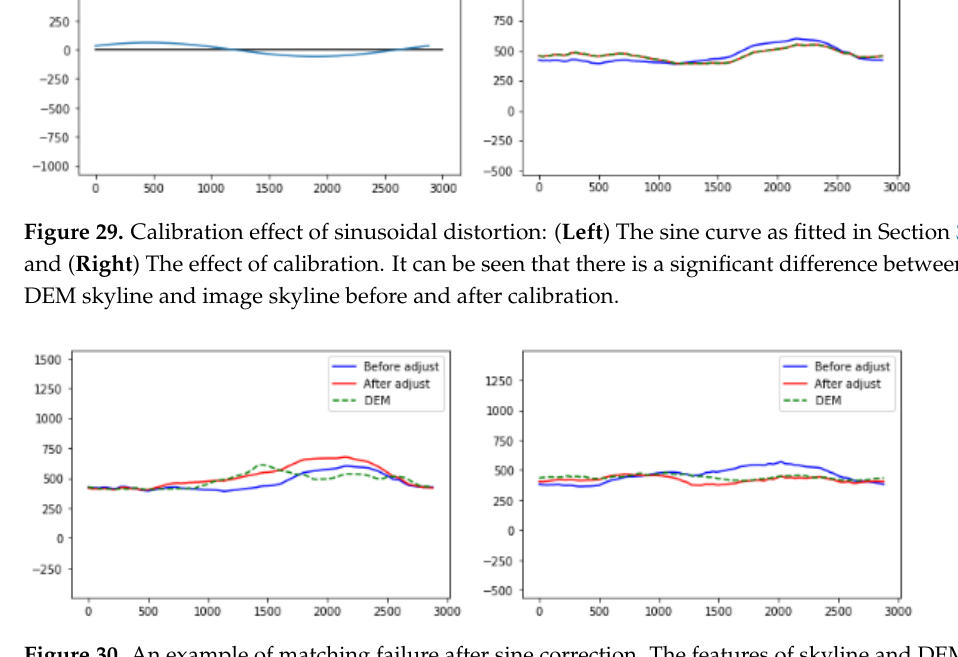
Figure 30. An example of matching failure after sine correction. The features of skyline and DEM are matched in the two maps, but after correction, the difference of skyline pairs is significant, indicating that the locations of DEM sampling points for comparison are not the locations of where the images were